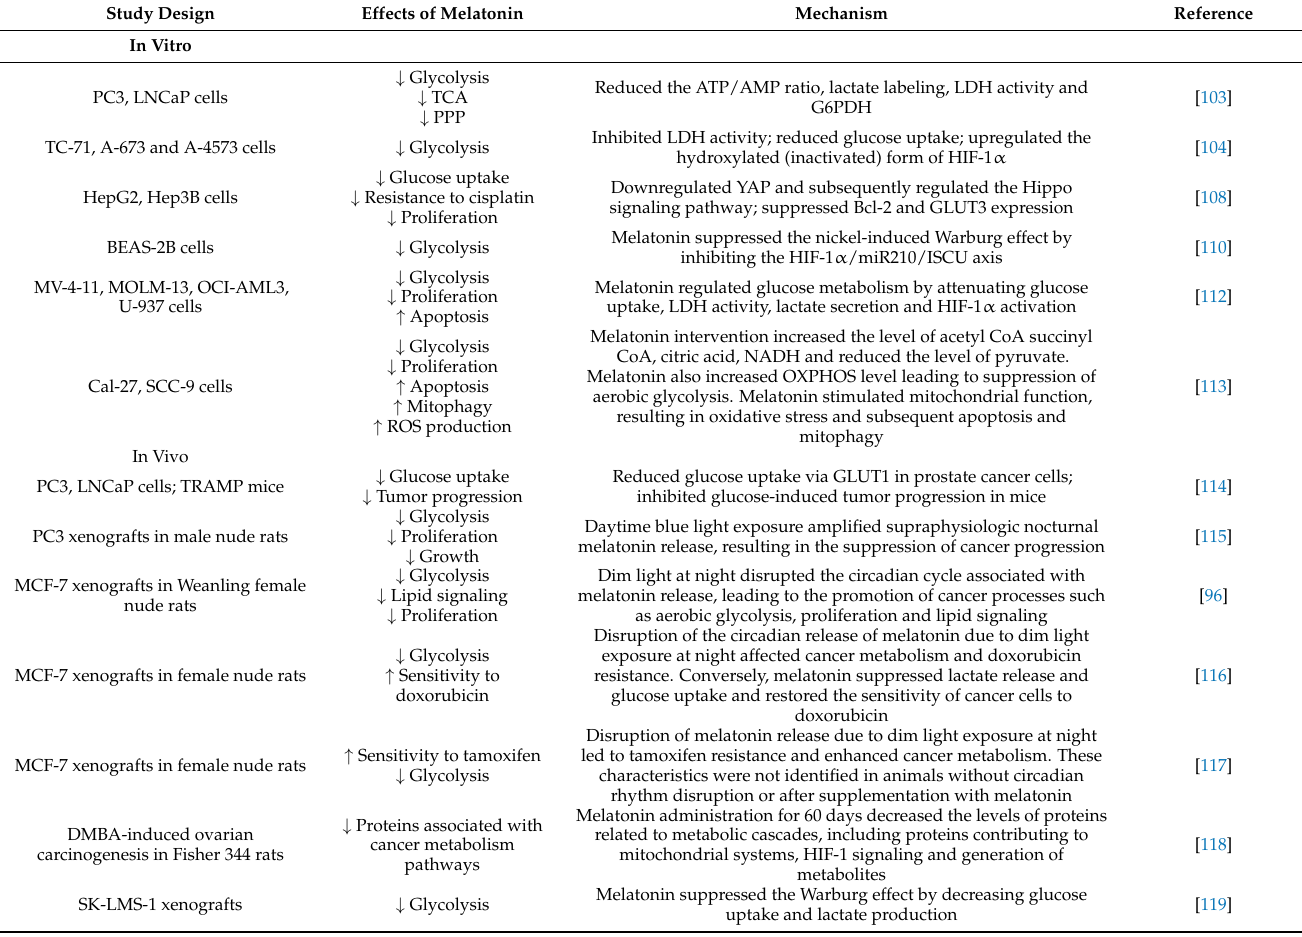
Table 1. Melatonin targeting cancer metabolism in preclinical